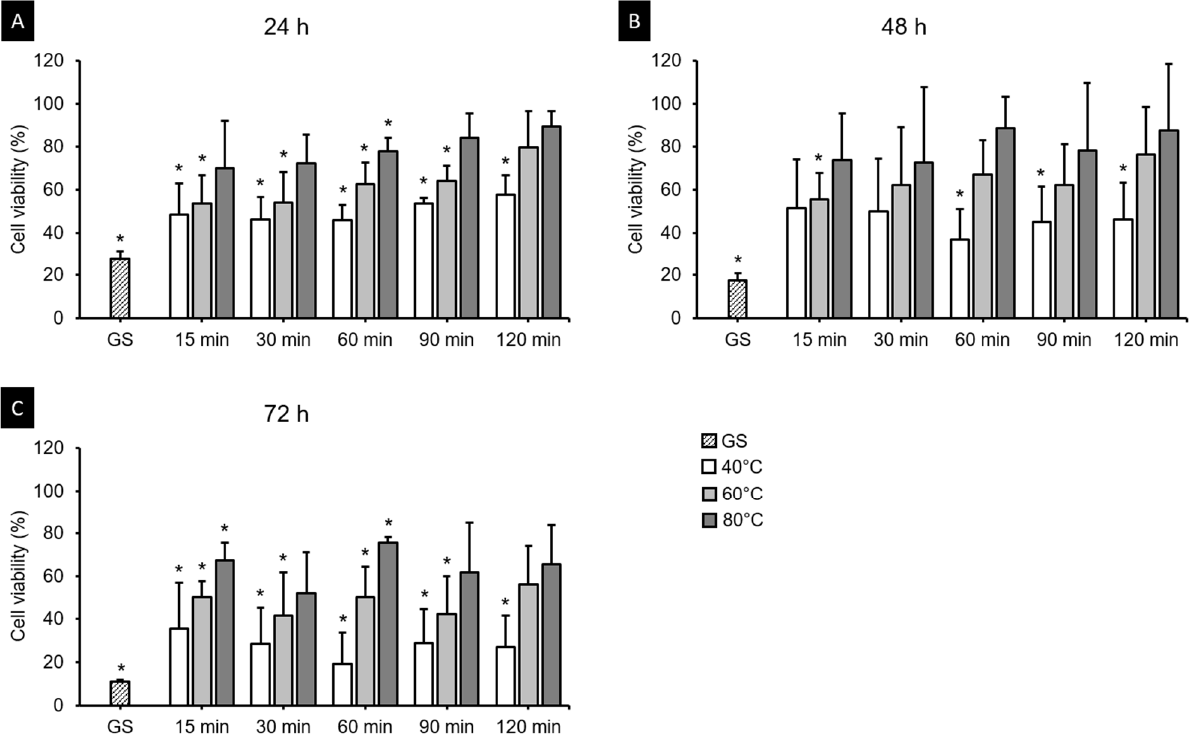
Figure 11. Results from cell viability assays. Cell viability increased with the postcuring temperature after ( A ) 24 h, ( B ) 48 h and ( C ) 72 h of experimentation. The cell viability gradually increased with the postcuring temperature and time. Mean and standard-deviation values are shown. Asterisk indicates a significant difference from the PC in the t -test.